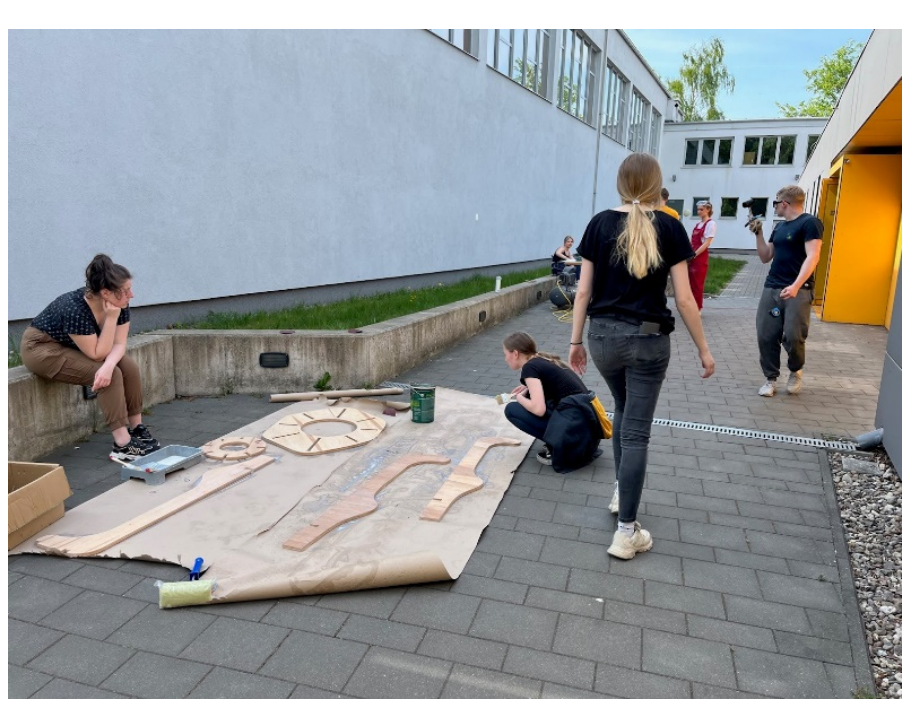
Figure 11. Manual processing.